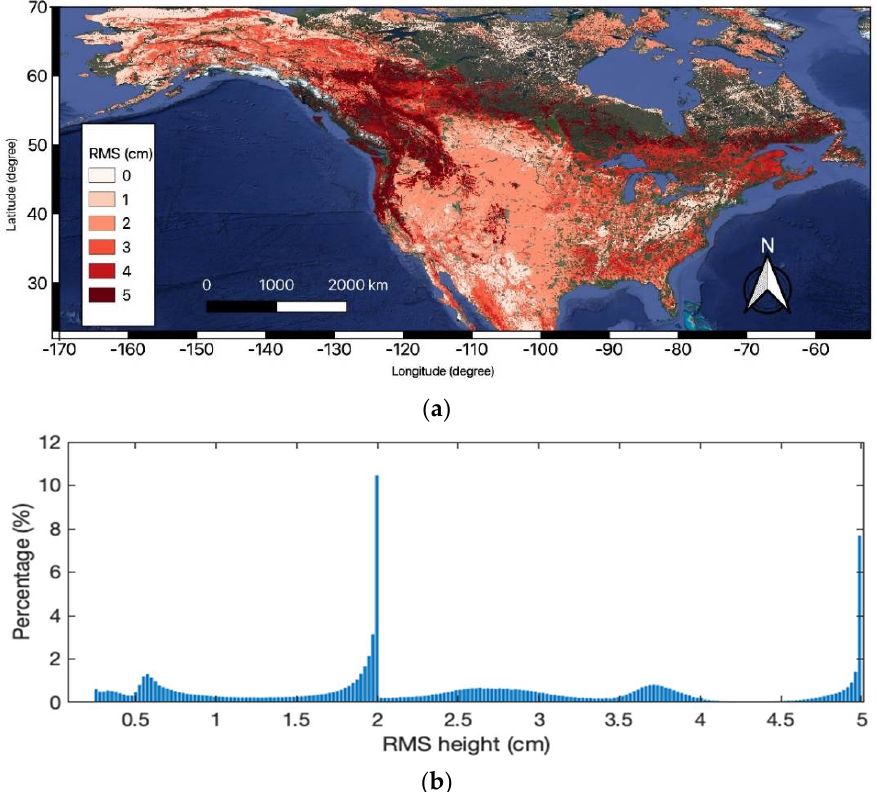
Figure 15. ( a ) Averaged rms height map from SMAP L3 SM product over North America and ( b ) histogram of soil rms height in percentage over North America.